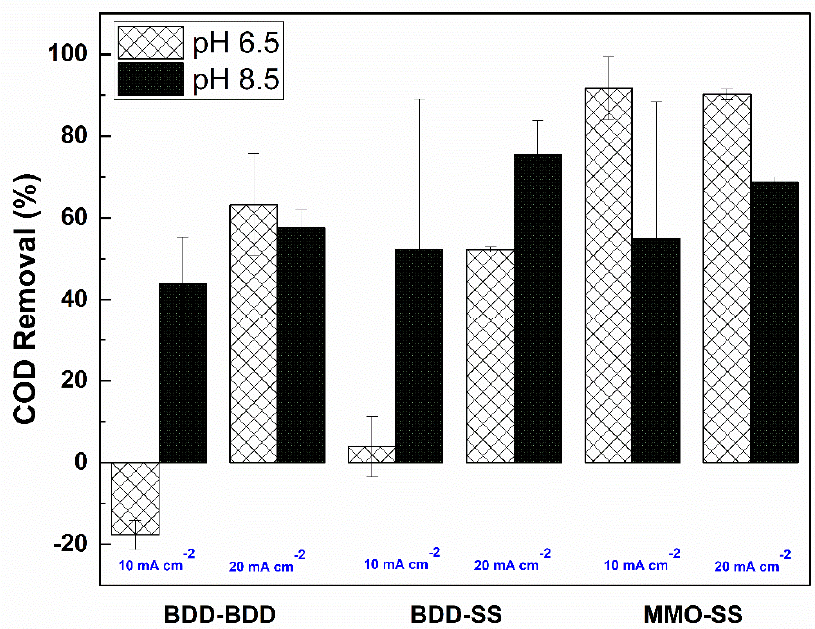
Figure 3. COD removal after 120 min after EO treatment with BDD and MMO electrodes at pH 6.5 and 8.5 and current densities of 10 and 20 mA cm − 2 . Error bars show standard deviation.